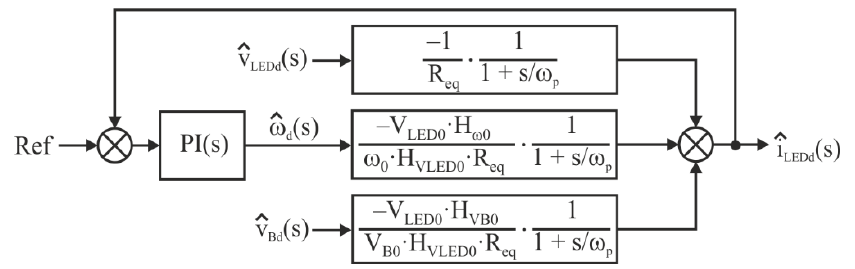
Figure 11. Small signal control loop.